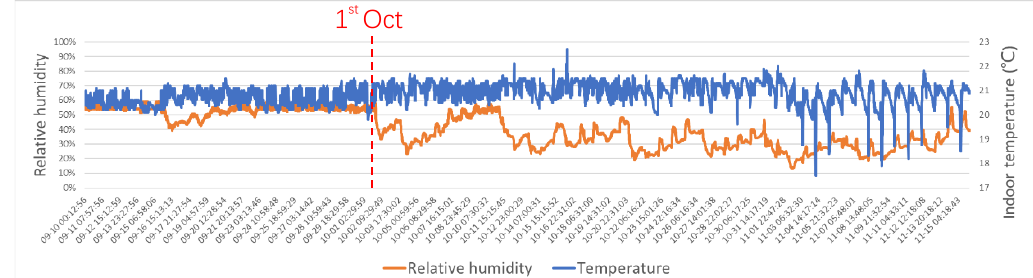
Figure 4. Temperature and relative humidity change curve of East Yanchi Building during the exhibition